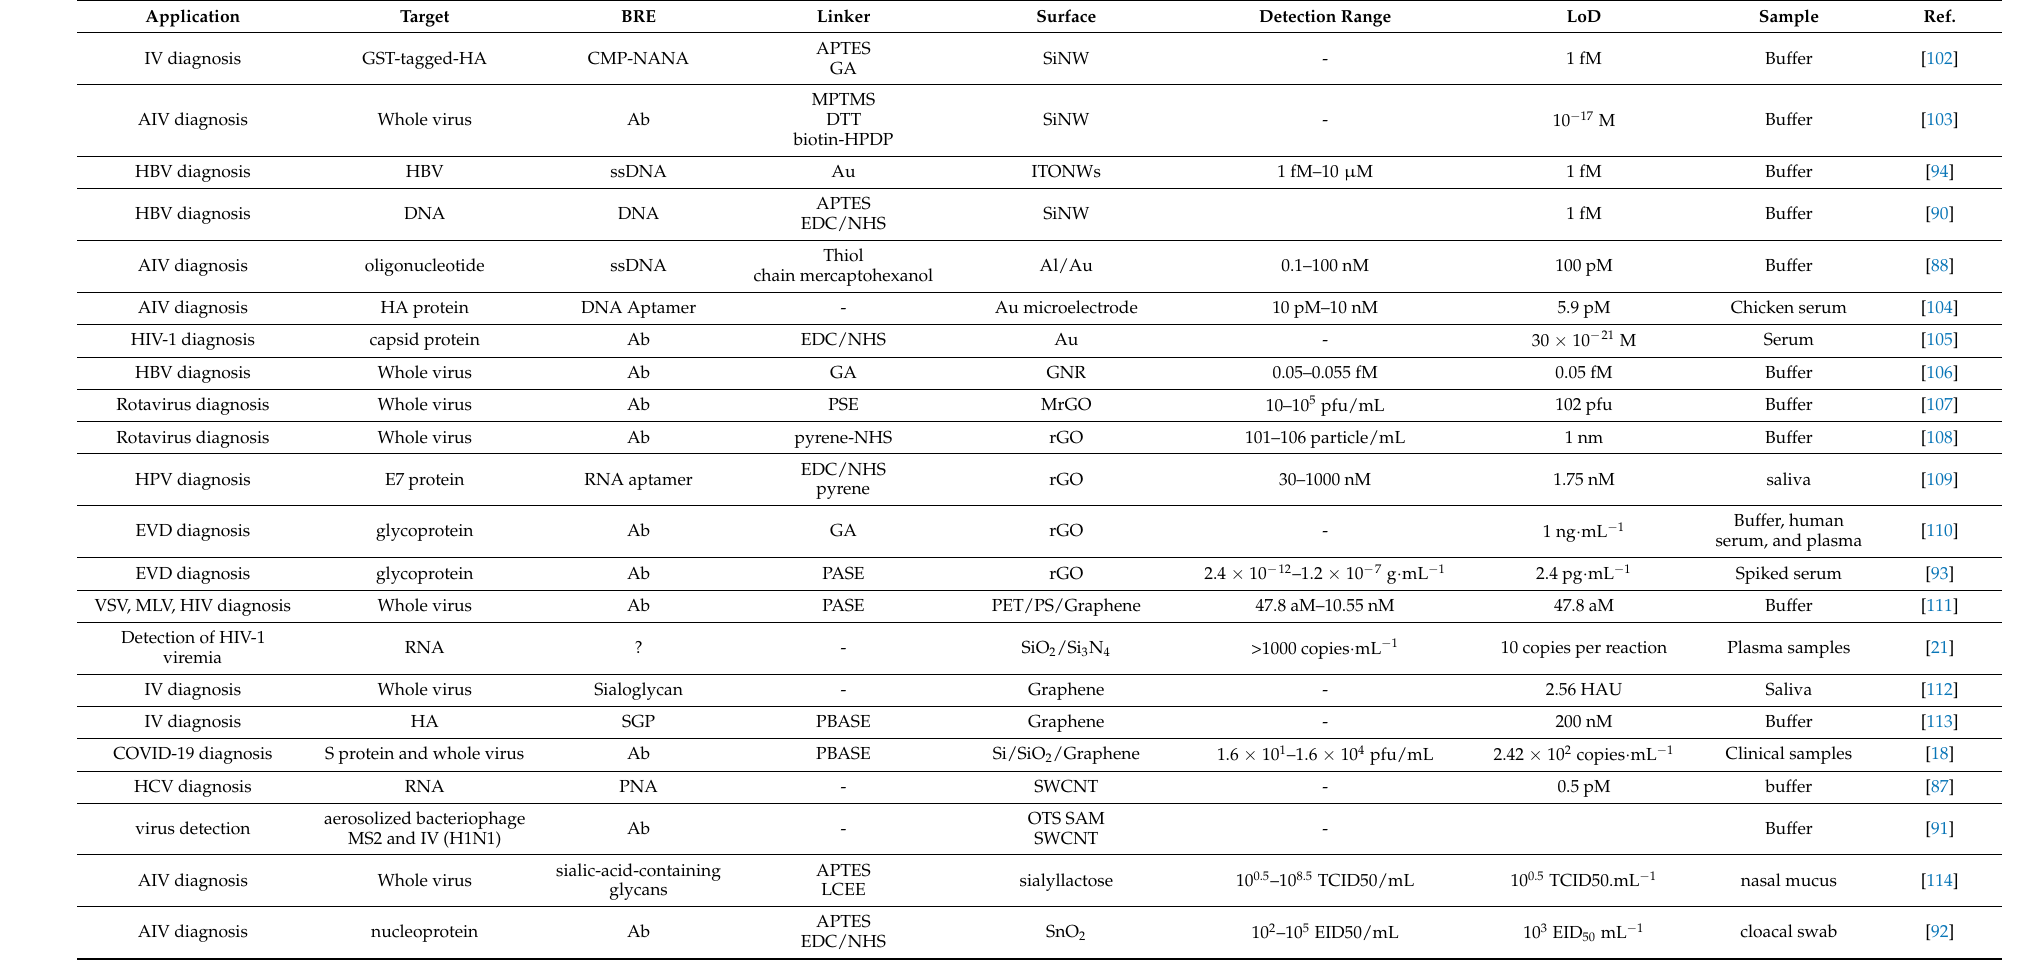
Table 1. Recently proposed FET biosensors for detecting various infectious